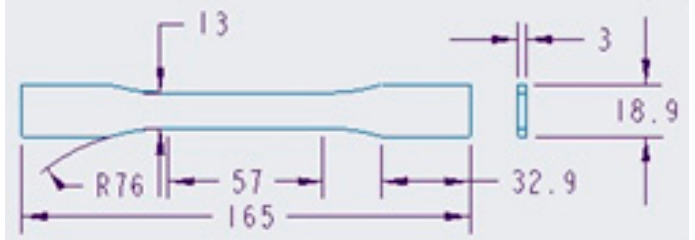
Figure 3. CAD design (in mm) of all the specimens that were subjected to tensile tests. This was the design of the three groups of specimens tested in this study: (i) DL400 resin specimens obtained by SLA; (ii) polypropylene specimens obtained in 3D printed DL400 polymer resin mold inserts; and